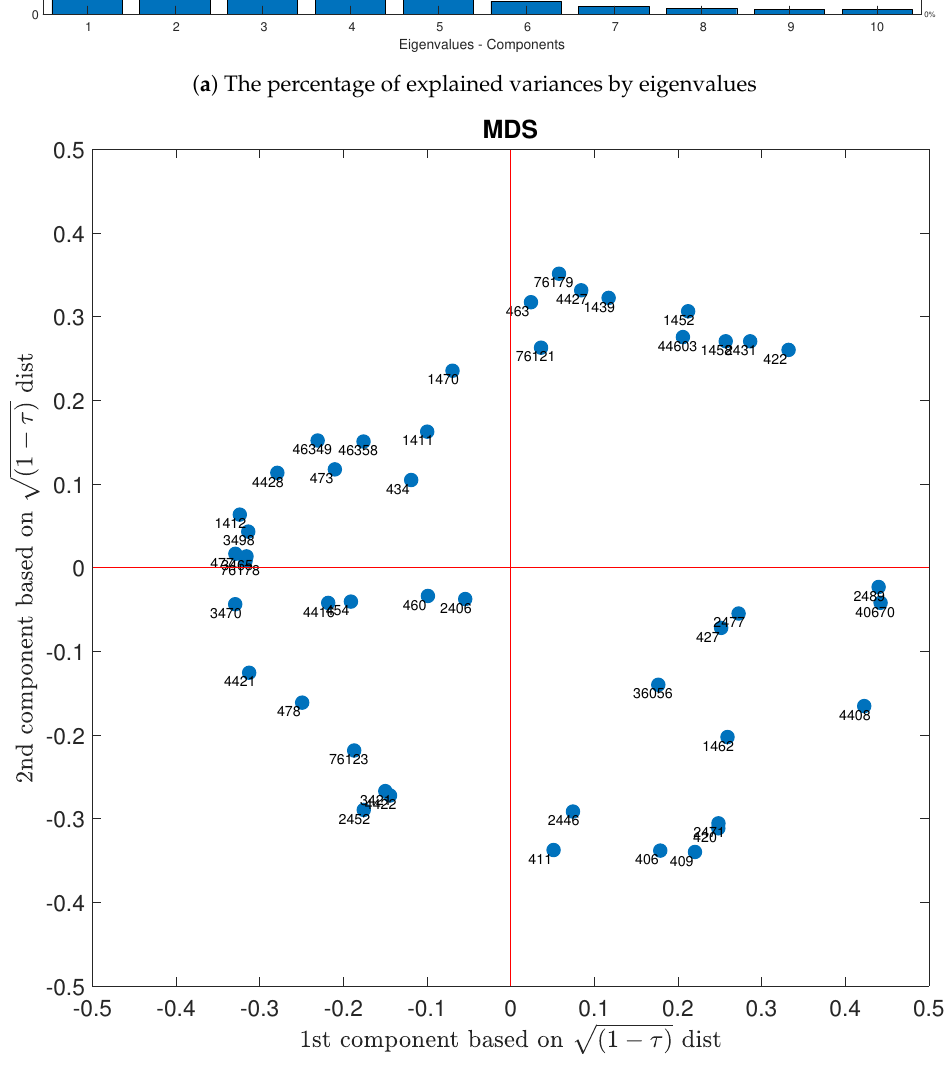
( b ) Scatter plot of two first principal components based on Kendall distance Figure 12. Multidimensional scaling of the biggest floods in the Neckar